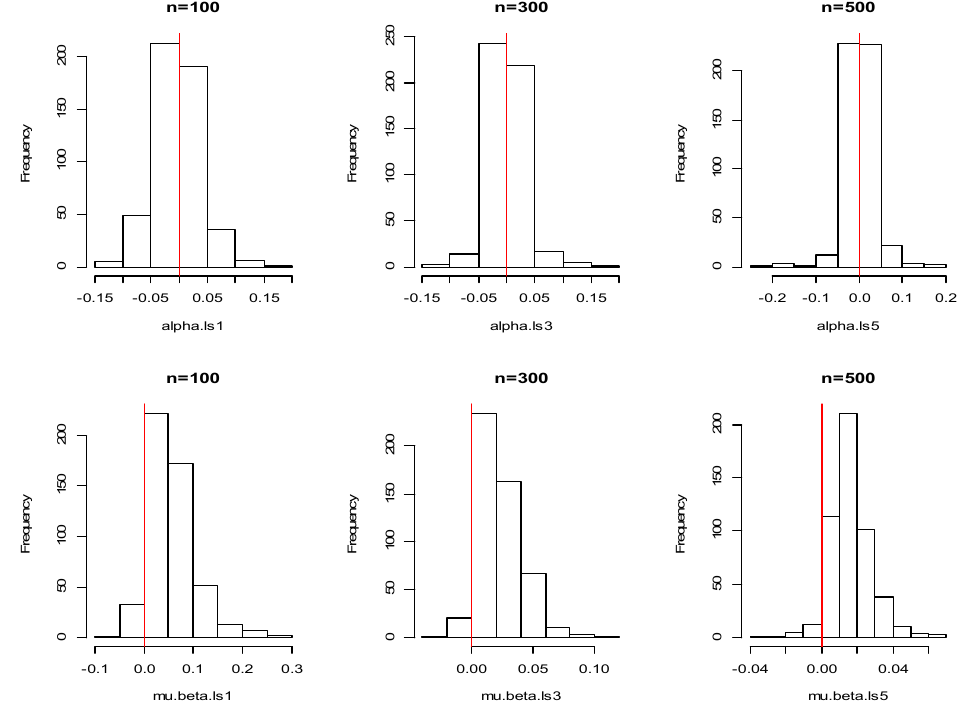
Figure 7. Histogram of estimated parameter α μ and β with the least-squares method in Case 4.